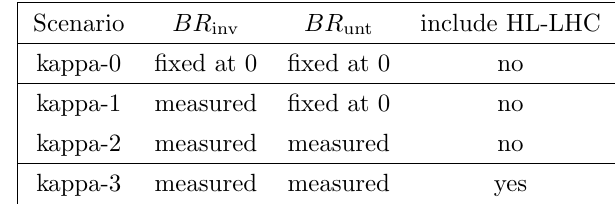
De(cid:12)nition of the benchmark scenarios used to characterize future colliders in the (cid:20)